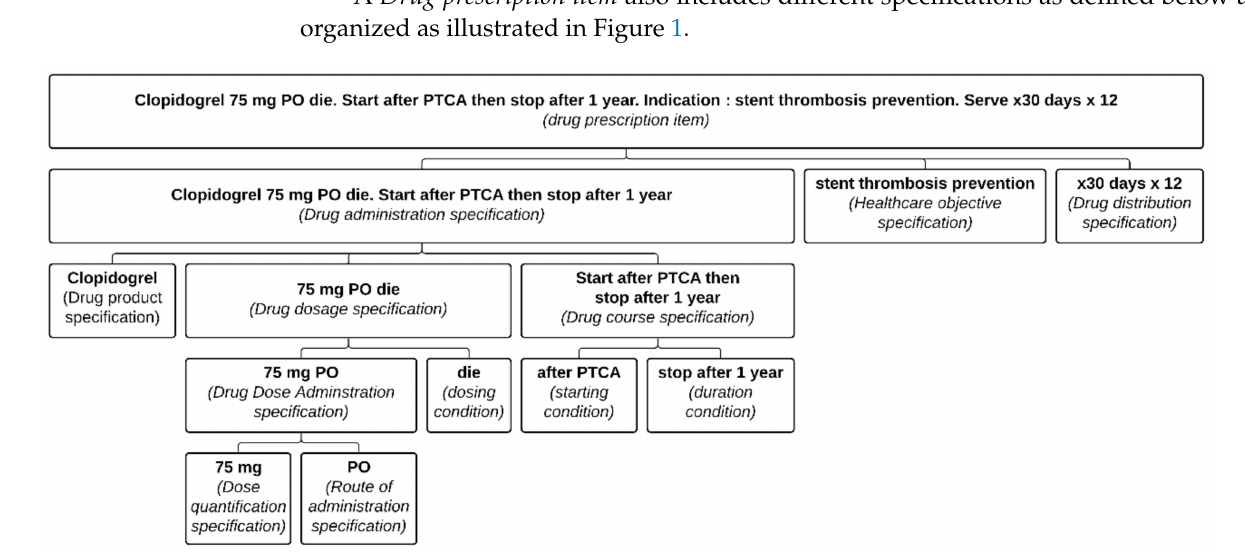
Figure 1. Representation of a well-defined Clopidogrel prescription item formalized in the PDRO ontology. Each part of the prescription item is associated with its relevant class. (PTCA: percutaneous transluminal coronary angioplasty; PO: per